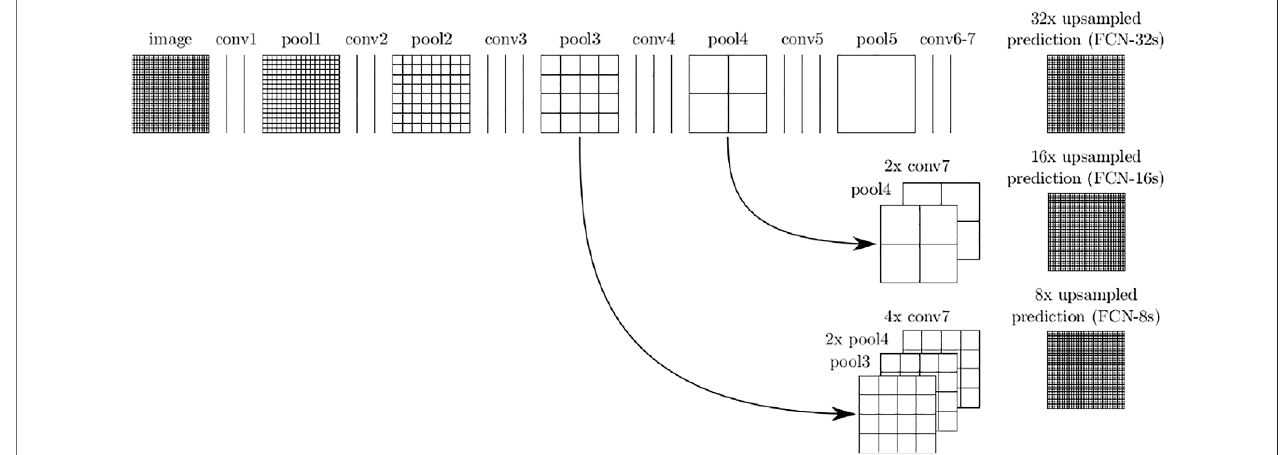
FIGURE 2 | FCNs architecture (Long et al., 2015).